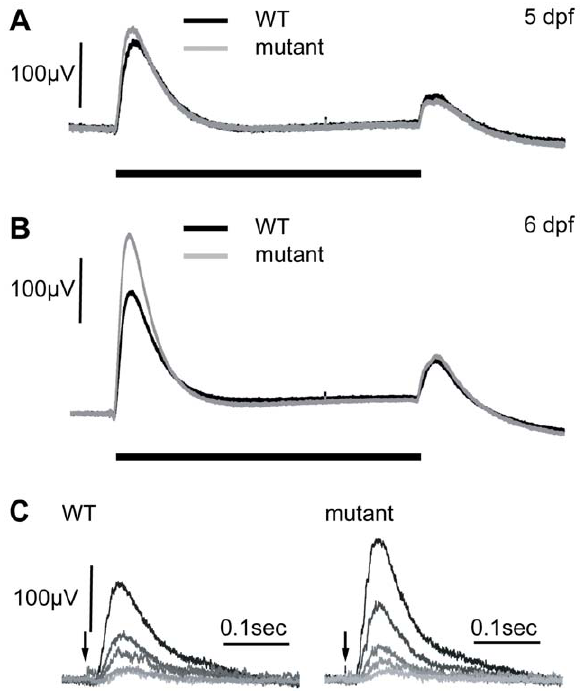
Figure 2. Electroretinograms show an increase in the b-wave response in mutants at 6 dpf. A) At 5 dpf, WT and zvm7 w65 responses are similar. B) At 6 dpf, zvm7 w65 eyes develop an increase in the b-wave. The b-wave was 176 6 13 m V in the WT (n=30) and 260 6 48 m V in the zvm7 w65 fish at 6 dpf (n=32) (p , .001). A) and B) show an average representative trace including at least 9 animals. C) WT and zvm7 w65 eyes have a similar light threshold response. Eyes were exposed to a millisecond light flash (arrow) at intensities differing by 0.5 log units (brightest=.41 mW). Amplitudes of mutant b-waves were larger at all light levels. Images show traces from a single